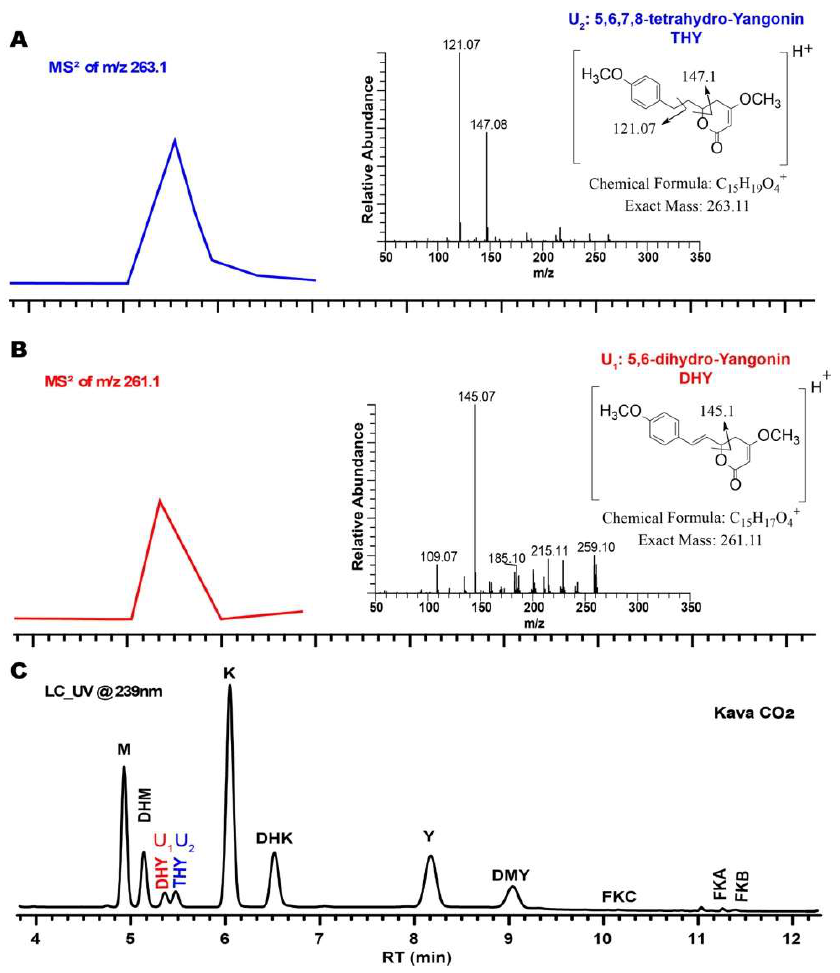
Figure 2. UHPLC-UV-MS data of kava CO 2 extract as follows: ( A ) MS/MS 2 trace of m / z 263.1 and MS 2 spectrum of peak U 2 (5,6,7,8-Tetrahydroyangonin, THY); ( B ) MS/MS 2 trace of m / z 261.1 and MS 2 spectrum of peak U 1 (5,6-Dihydroyangonin, DHY); ( C ) UV trace at the wavelength of 239 nm; M, methysticin; DHM, 7,8-Dihydromethysticin; K, kavain; DHK, 7,8-Dihydrokavain; Y, yangonin; DMY, desmethoxyyangonin; FKA (B or C) flavokavains A (B or C).